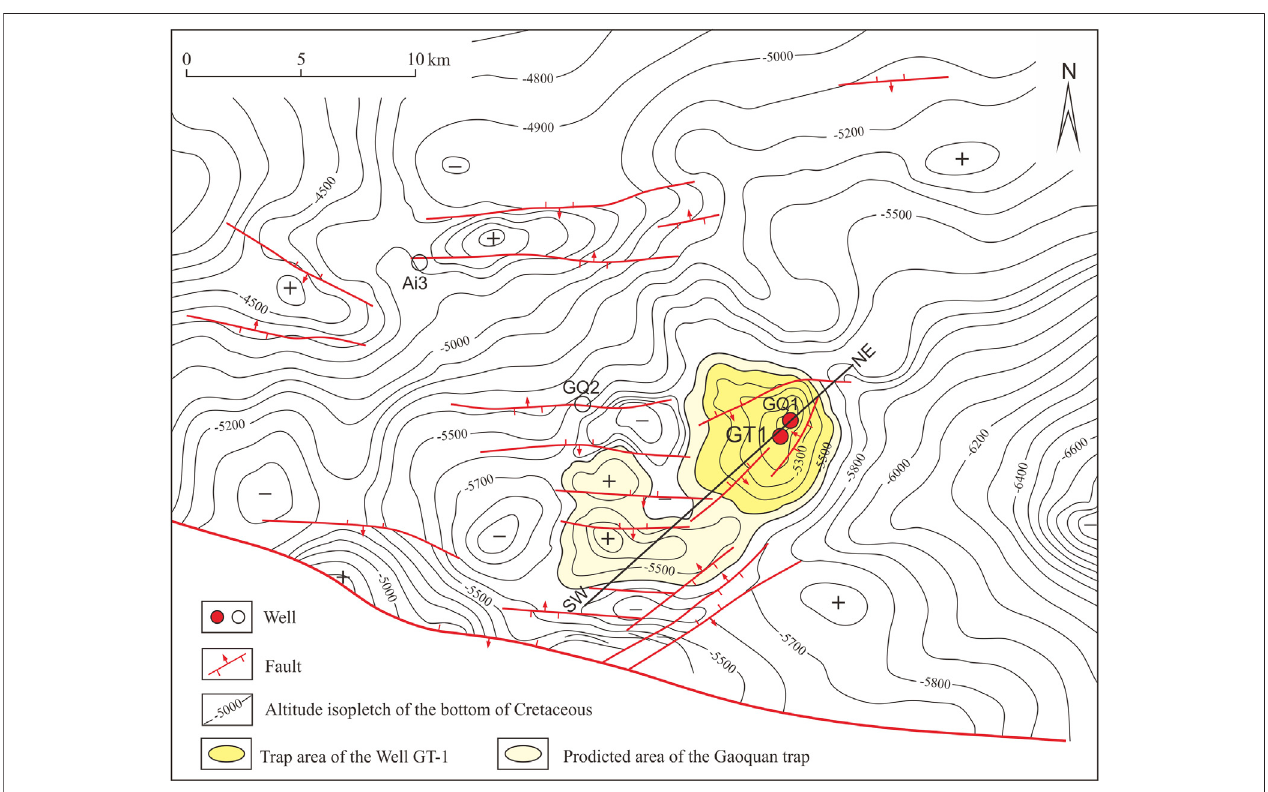
FIGURE 3 | Structural map of Gaoquan anticline and adjacent Cretaceous bottom boundary in west of southern margin.